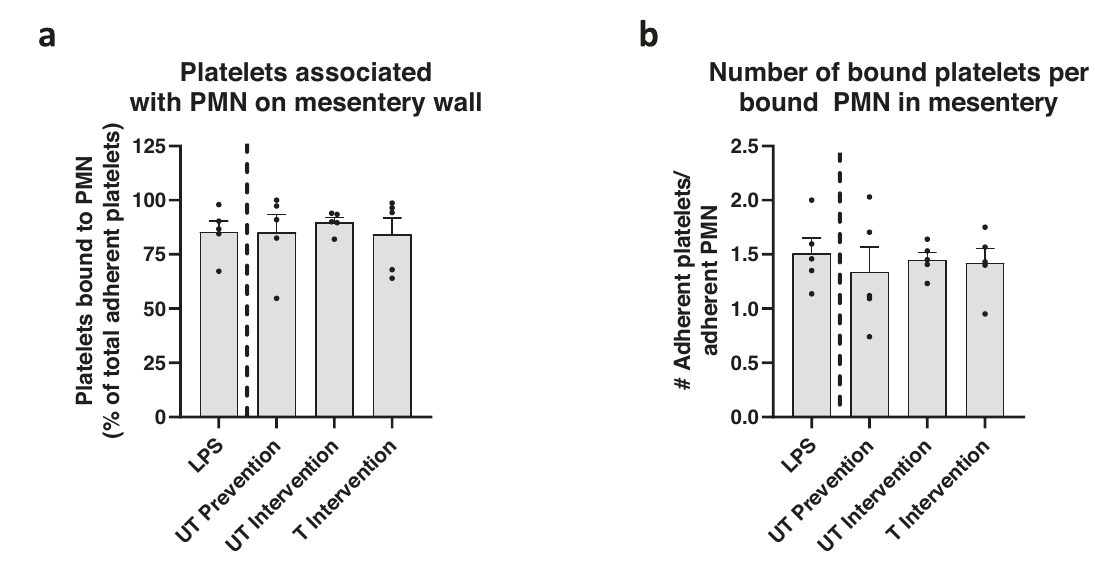
lipopolysaccharide, ‘ UT ’ to untargeted, and ‘ T ’ to targeted particles. Statistical analyses were performed using a one-way ANOVA with Tukey ’ s multiple compar- isons. Lack of symbols indicates no statistical signi fi cance. Circles represent indi- vidual data points, bar graph represents the average of individual data points, and errorbarsrepresentstandard error.Sourcedataandspeci fi c p -valuesareprovided as a Source Data fi